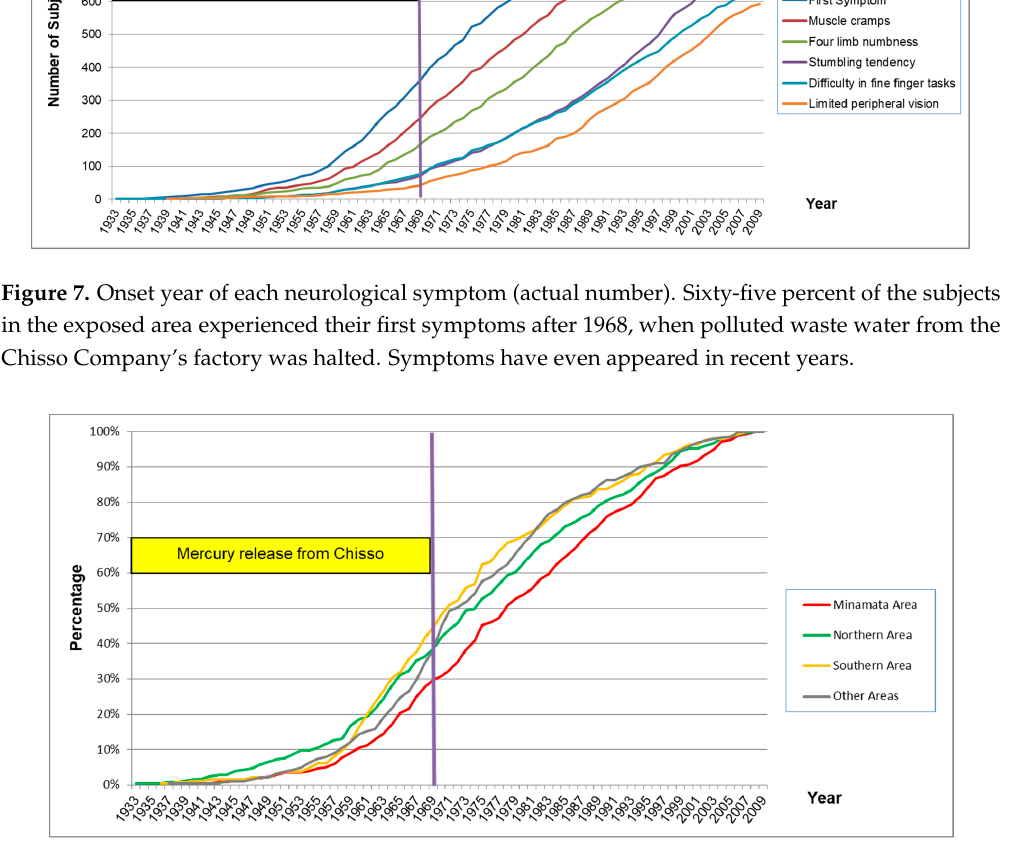
Figure 8. Onset year of the first symptom in each exposed group (percentage). Cumulative curves of the onset were almost the same among the four exposed groups.